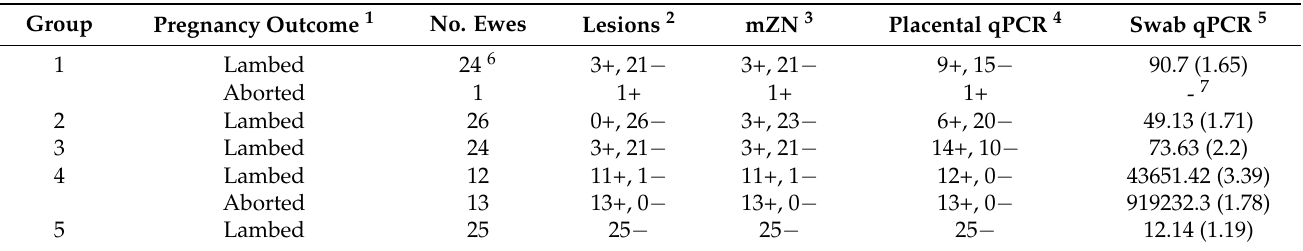
1 See Table 1. 2 Number of ewes with gross pathological lesions characteristic of C. abortus infection evident in one or more placentas. 3 Detection of chlamydial organisms following staining of placental smears: +, positive; − , negative. 4 Quantitative real-time polymerase chain reaction (qPCR) detection of C. abortus DNA in the cotyledons tested by modified Ziehl-Neelsen (mZN). 5 Geometric mean (geometric SEM) of the number of C. abortus genomes detected per µ L total DNA of swab extract. 6 Includes lamb that died of dystocia/asphyxiation. 7 The summary statistics cannot be computed for a single